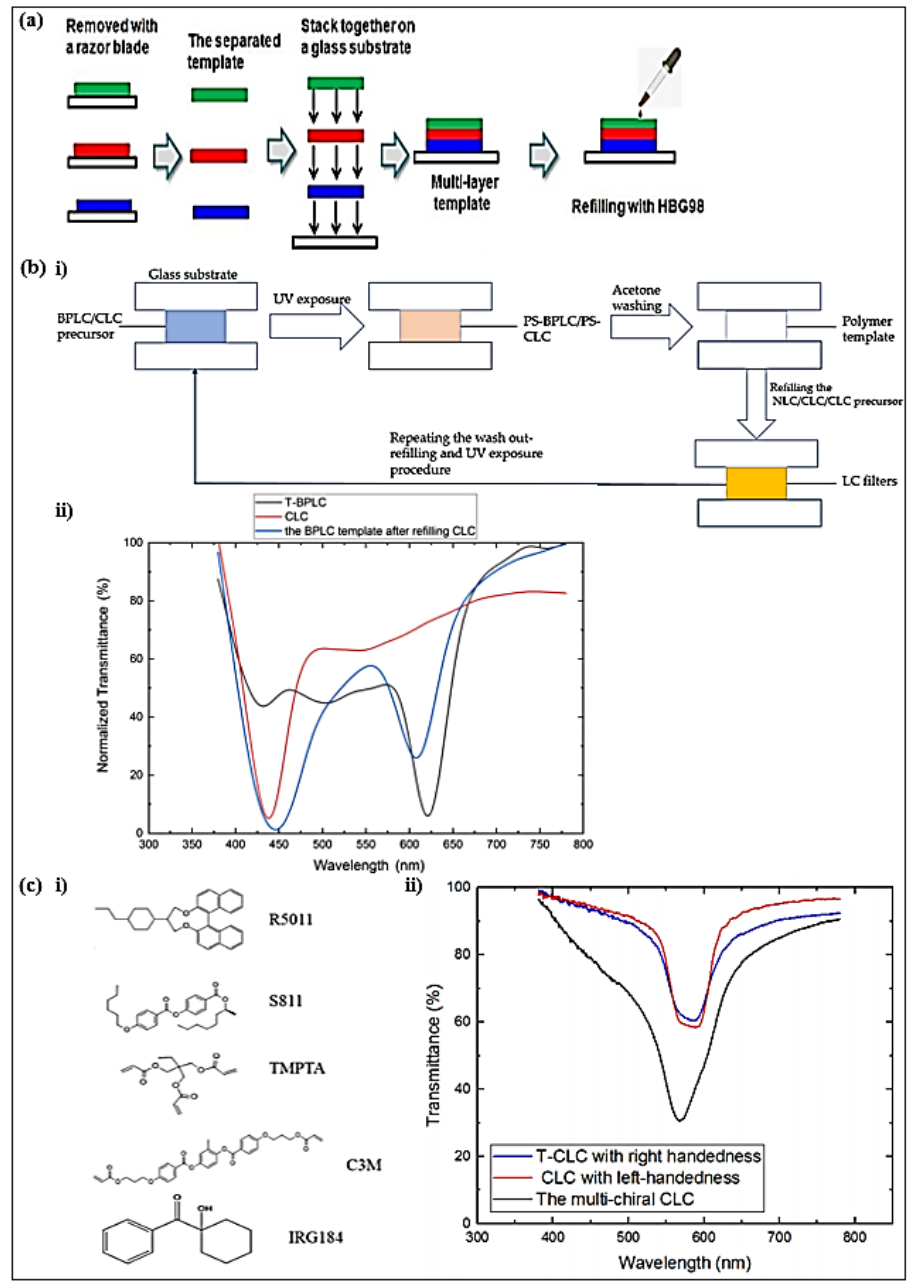
Figure 2. ( a ) The fabrication process of the multi-layer templated BPLC filter. Reproduced with per- mission from Ref. [62]. MDPI, 2019. ( b ) i) Flow chart of multiple refilling process. ii) Transmittance spectra of templated-BPLC, CLC, and dual-wavelength LC filter. Reproduced with permission from Ref. [63]. MDPI, 2021. ( c ) i) Materials used in experiments. ii) Transmission spectra of multi-chiral CLC filters with single layer. Reproduced with permission from Ref. [64]. MDPI, 2021. Compared to the LC filter with a multi-layer structure, a single-layer structure LC filter could significantly simplify the device structure and streamline the fabrication pro- cess. Hence, a multi-wavelength TSLC filter and a bandwidth-tunable CLC filter of a sin- gle-layer structure were implemented with a multiple wash-out – refilling process [63]. By